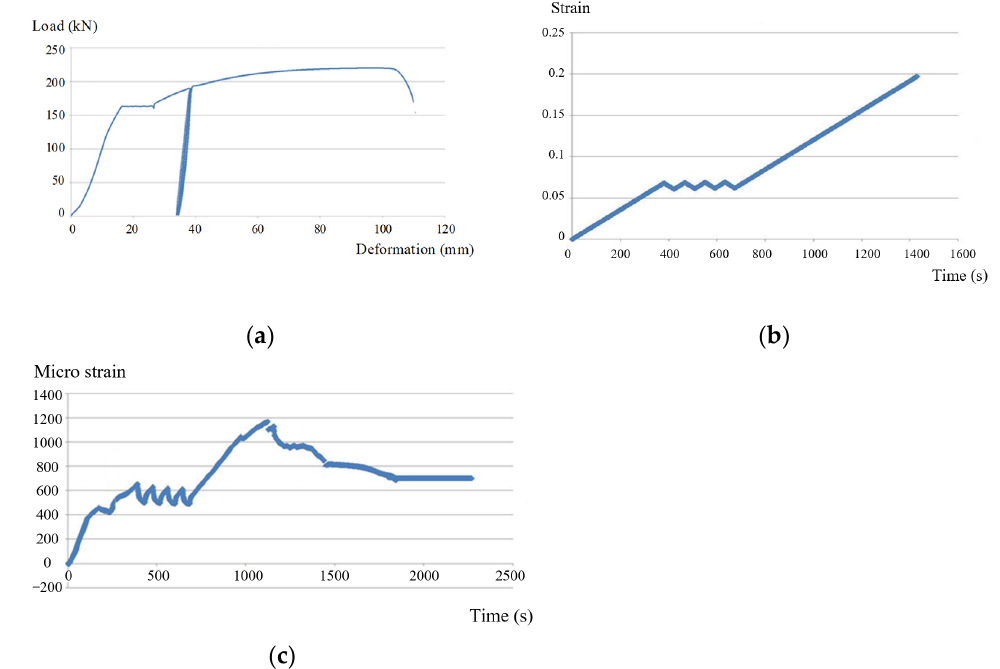
Figure 10. Variation diagram of loading, bolt strain and FBG micro-strain with time. ( a ) The loading diagram of the bolt; ( b ) bolt strain diagram; ( c ) FBG micro-strain diagram.